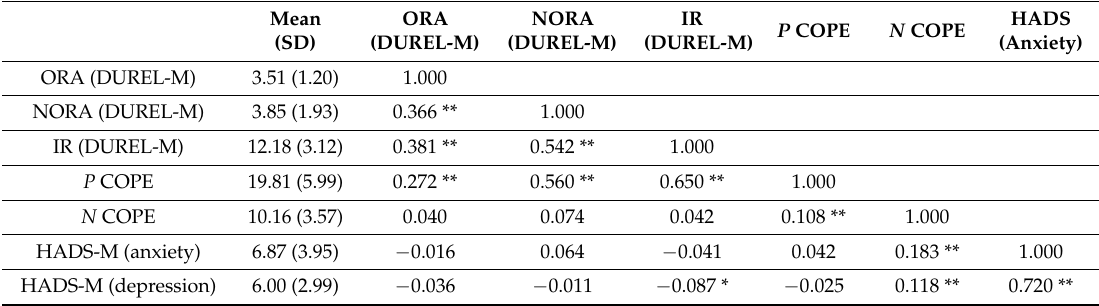
Table 5. Spearman correlation analyses between religious-type scaled variables, anxiety and depressive symptoms.